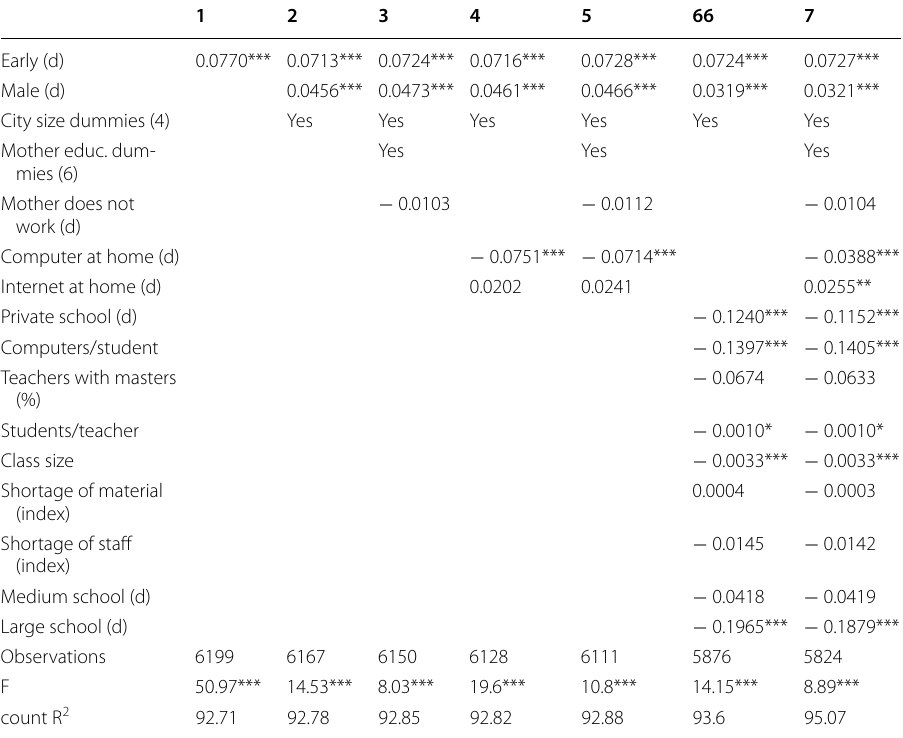
Table 5 Probability of having repeated at least one school year Source: Own estimation with data from PISA 2018,